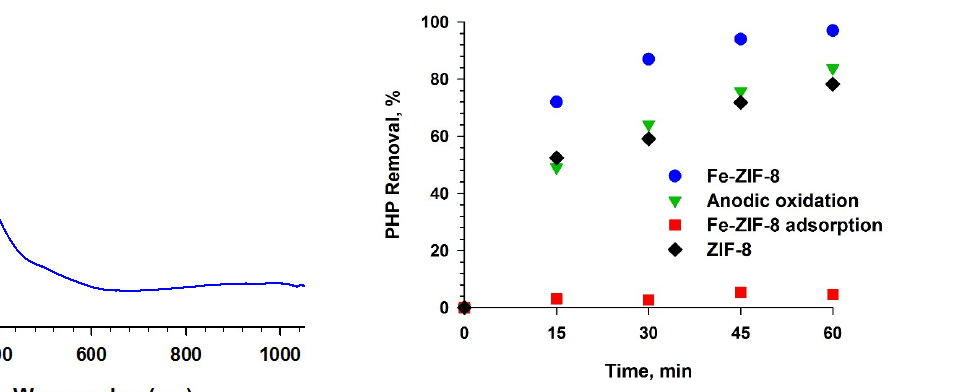
Fig. 6. Comparison of the ZIF-8 and Fe-ZIF-8 nanocatalysts. Re- action conditions: 0.1 A, pH = 7, [catalyst] = 0.2 gL -1 , and [PHP]= 10